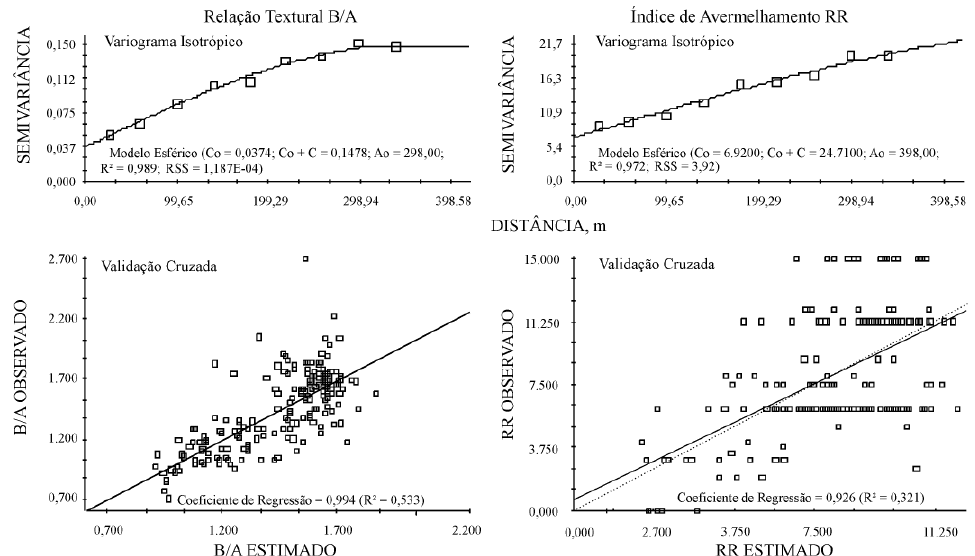
Figura 4. Modelos esféricos de semivariograma e testes de validação cruzada para os atributos relação textural (RT) e índice de avermelhamento